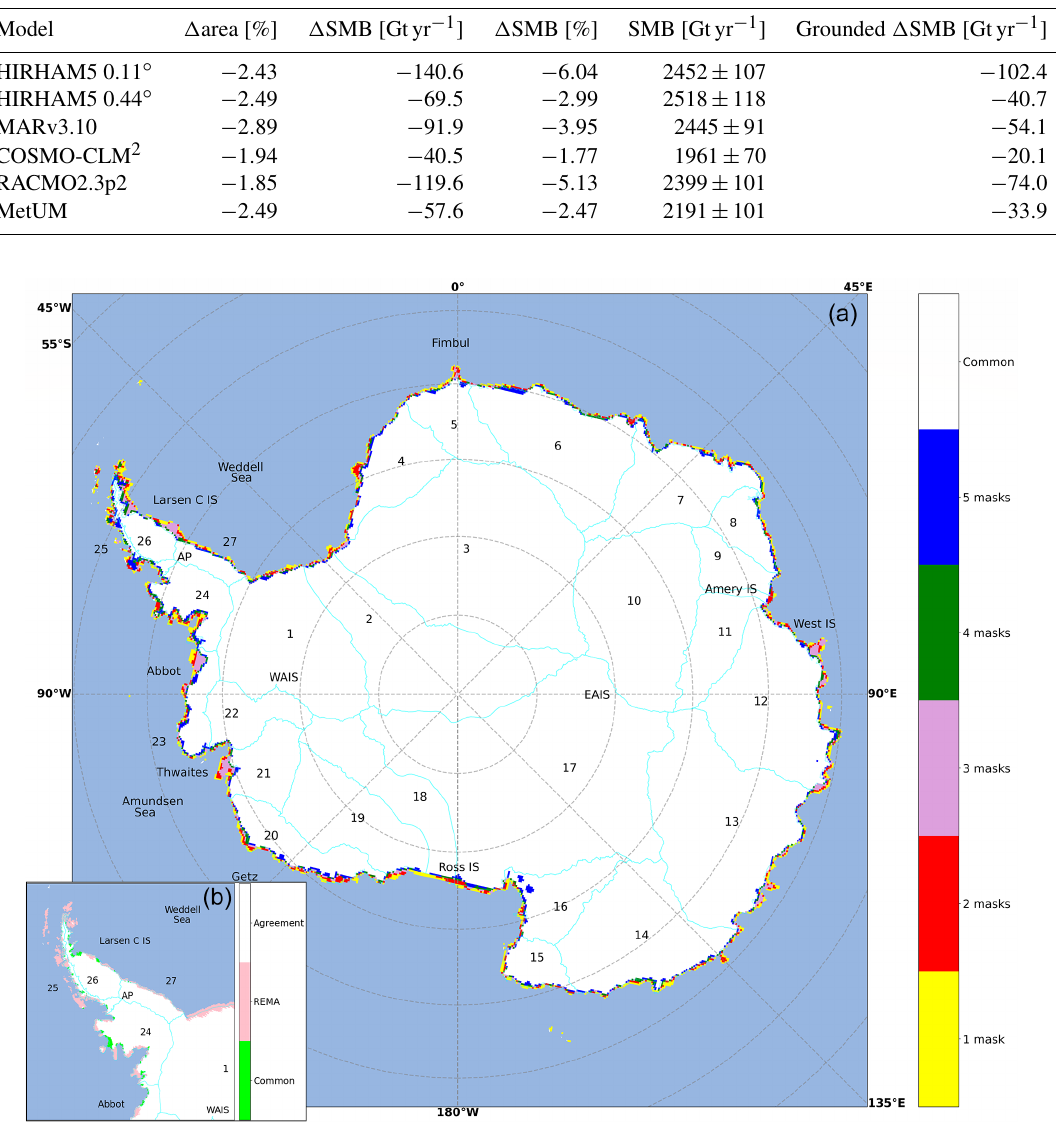
Figure 1. Panel (a) shows the ice mask agreement; the white area is the common mask (i.e. where all six masks have ice), and the colours around the coastline represents the number of native masks that have ice outside the common mask. The numbers refer to the 27 drainage basins with ice shelves, outlined in turquoise, and IS is short for ice shelf and AP, WAIS and EAIS are the Antarctic Peninsula, West AIS and East AIS respectively. Panel (b) is a section of the AP displaying the REMA mask, the common mask and where they